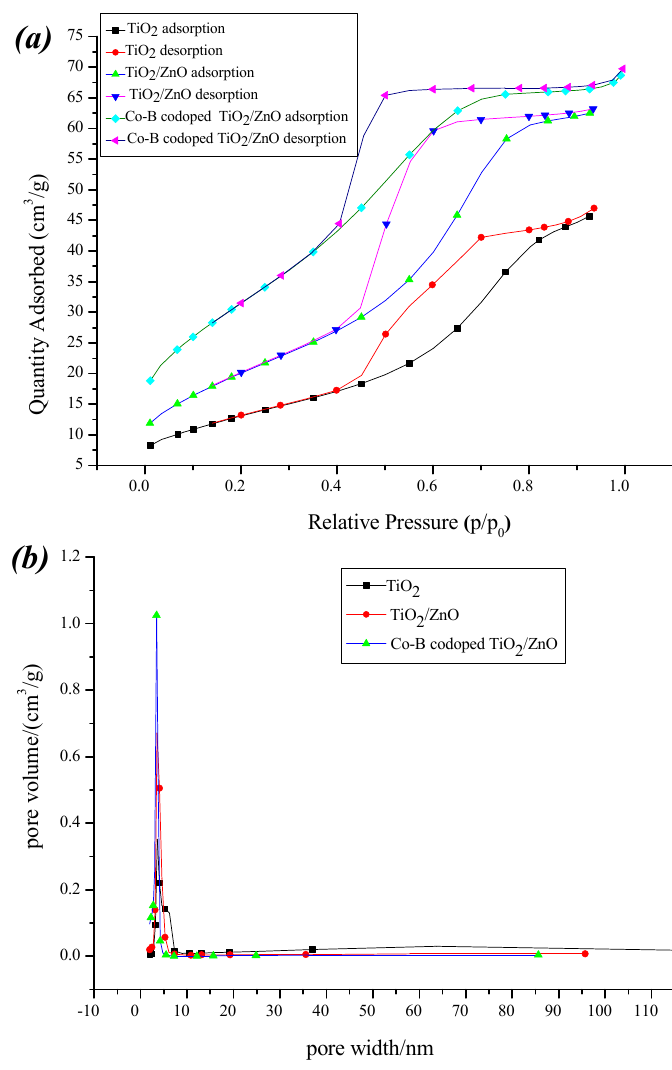
Figure 10. N 2 adsorption/desorption isotherms ( a ) and pore size distribution ( b ) of pure TiO 2 , composite TiO 2 /ZnO, and Co-B codoped TiO 2 /ZnO powders.